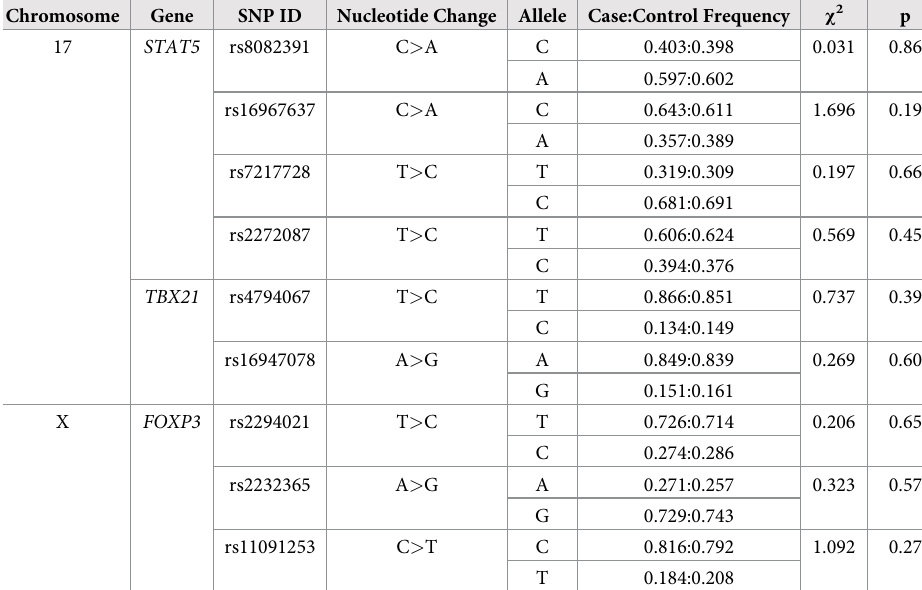
and linear regression models, respectively. Firstly, in a logistic model, results corroborated those previously outlined, as PC6 (representing IL4 SNPs rs2070874, rs2243259 and rs2243248) was associated with decreased odds of S . haematobium infection (OR = 0.8026, 95% CIs: 0.6713–0.9595, p = 0.016) ( S6 Appendix) . In a linear model, no PC was significantly associated with infection intensity ( S6 Appendix ). Linear regression identified a number of relationships between PCs and cytokine concen- trations ( Fig 5 and Table 6 ). PC10, representing STAT6 SNPs rs11172106 and rs324015, was associated with the largest number of cytokine responses–elevated systemic IL-4